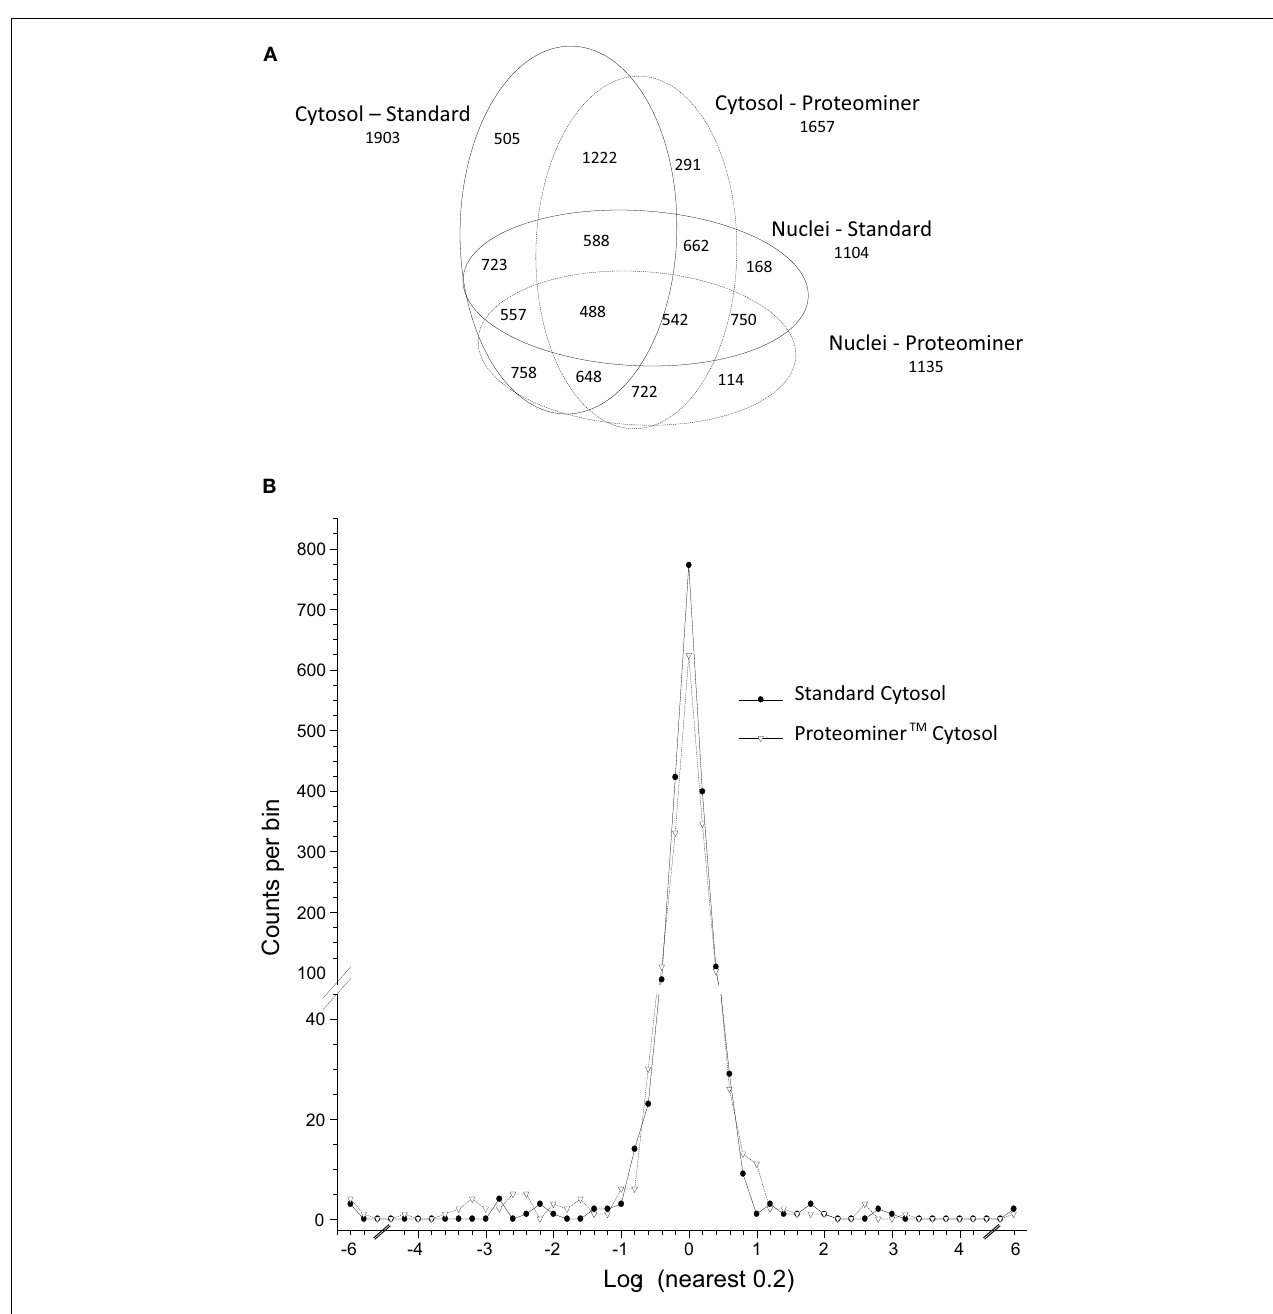
up-regulated host proteins in virus-infected cells; negative values represent down-regulated host proteins. Characteristics of all peptide and protein distributions, mean log 2 H:L ratios, and SDs of log 2 H:L ratios are shown in Table 1